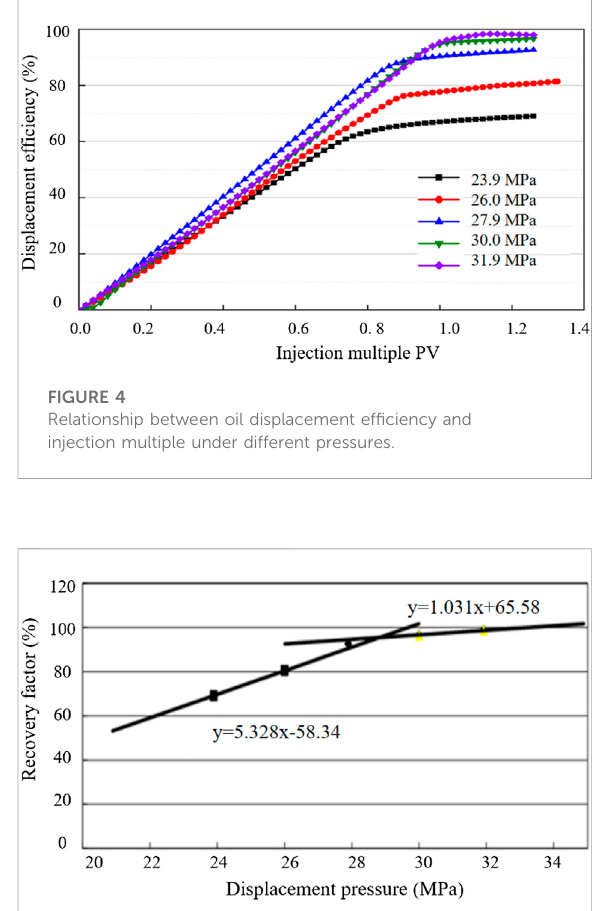
FIGURE 5 Determination of minimum miscible pressure.